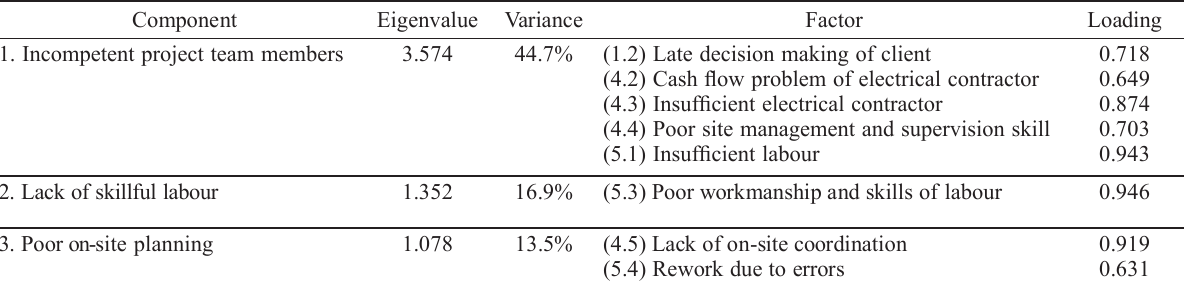
Table 4. Result of factor